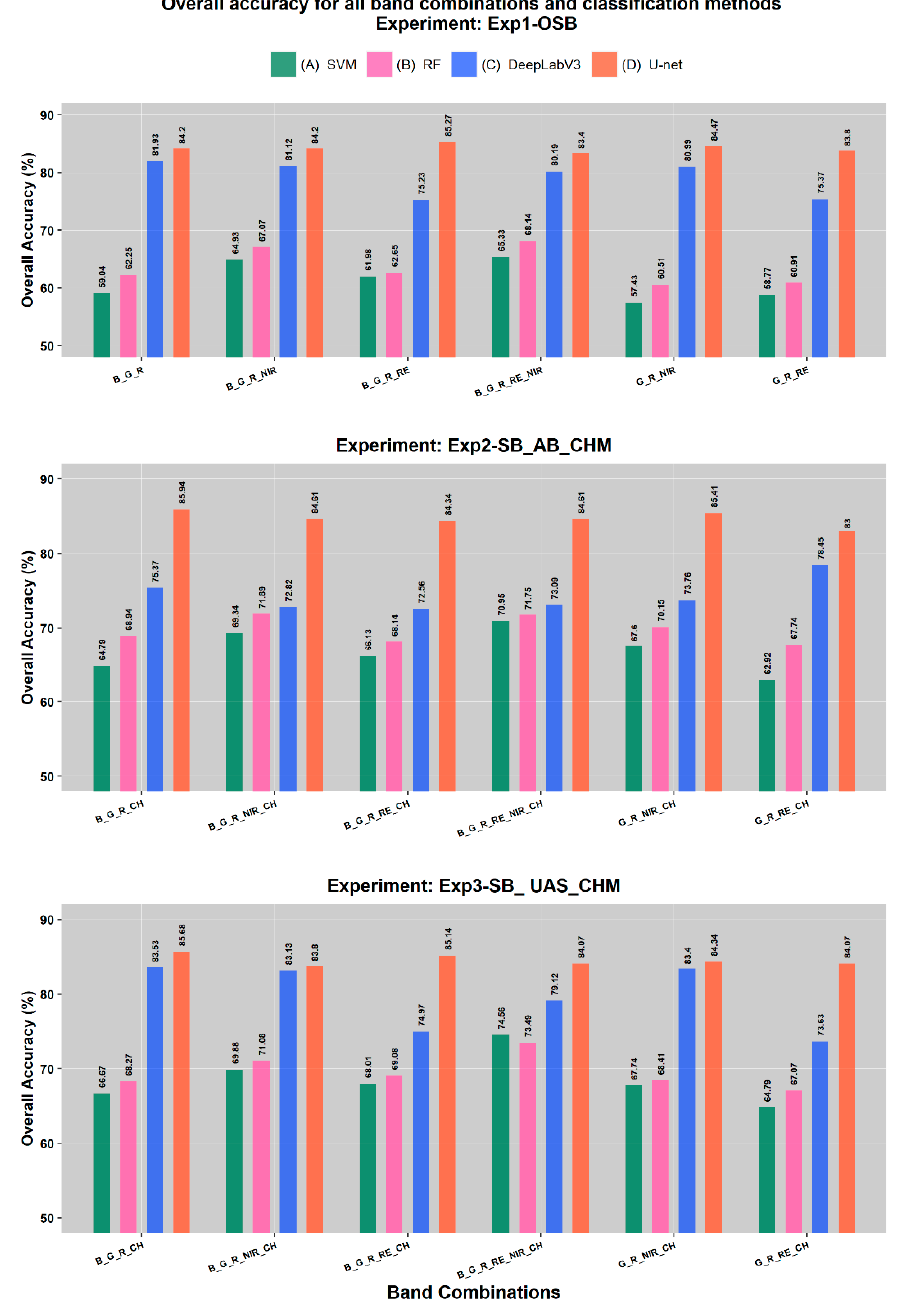
Figure 12. Overall accuracy of all conducted trials.